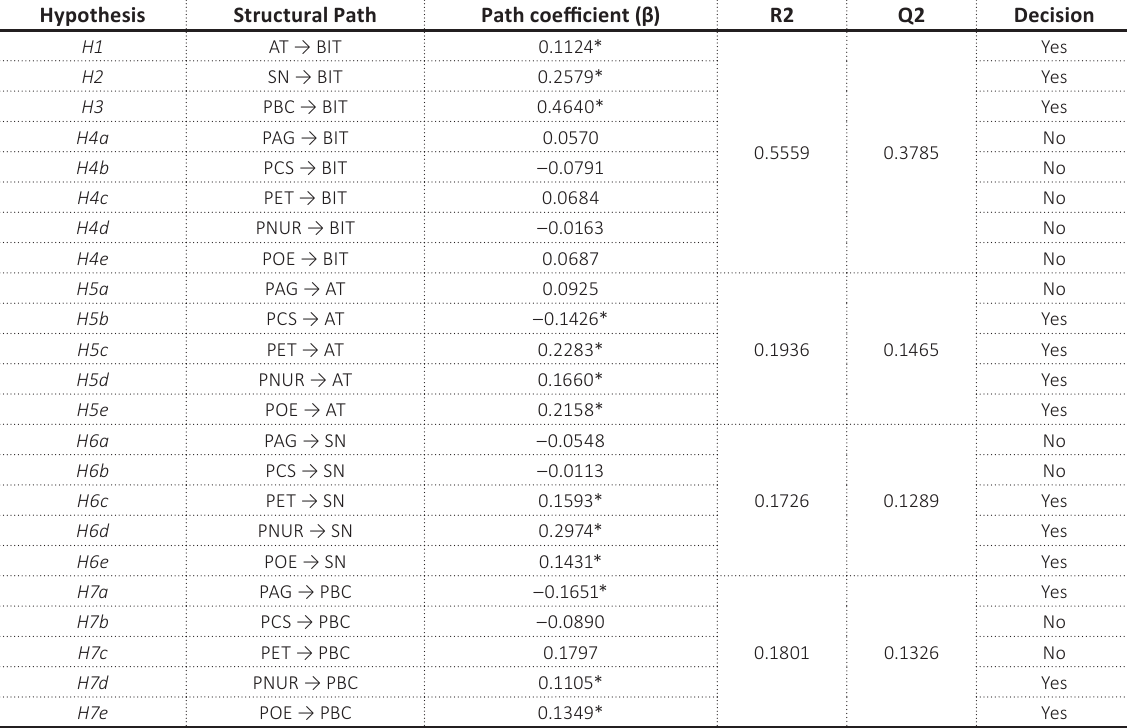
Table 6. Structural path